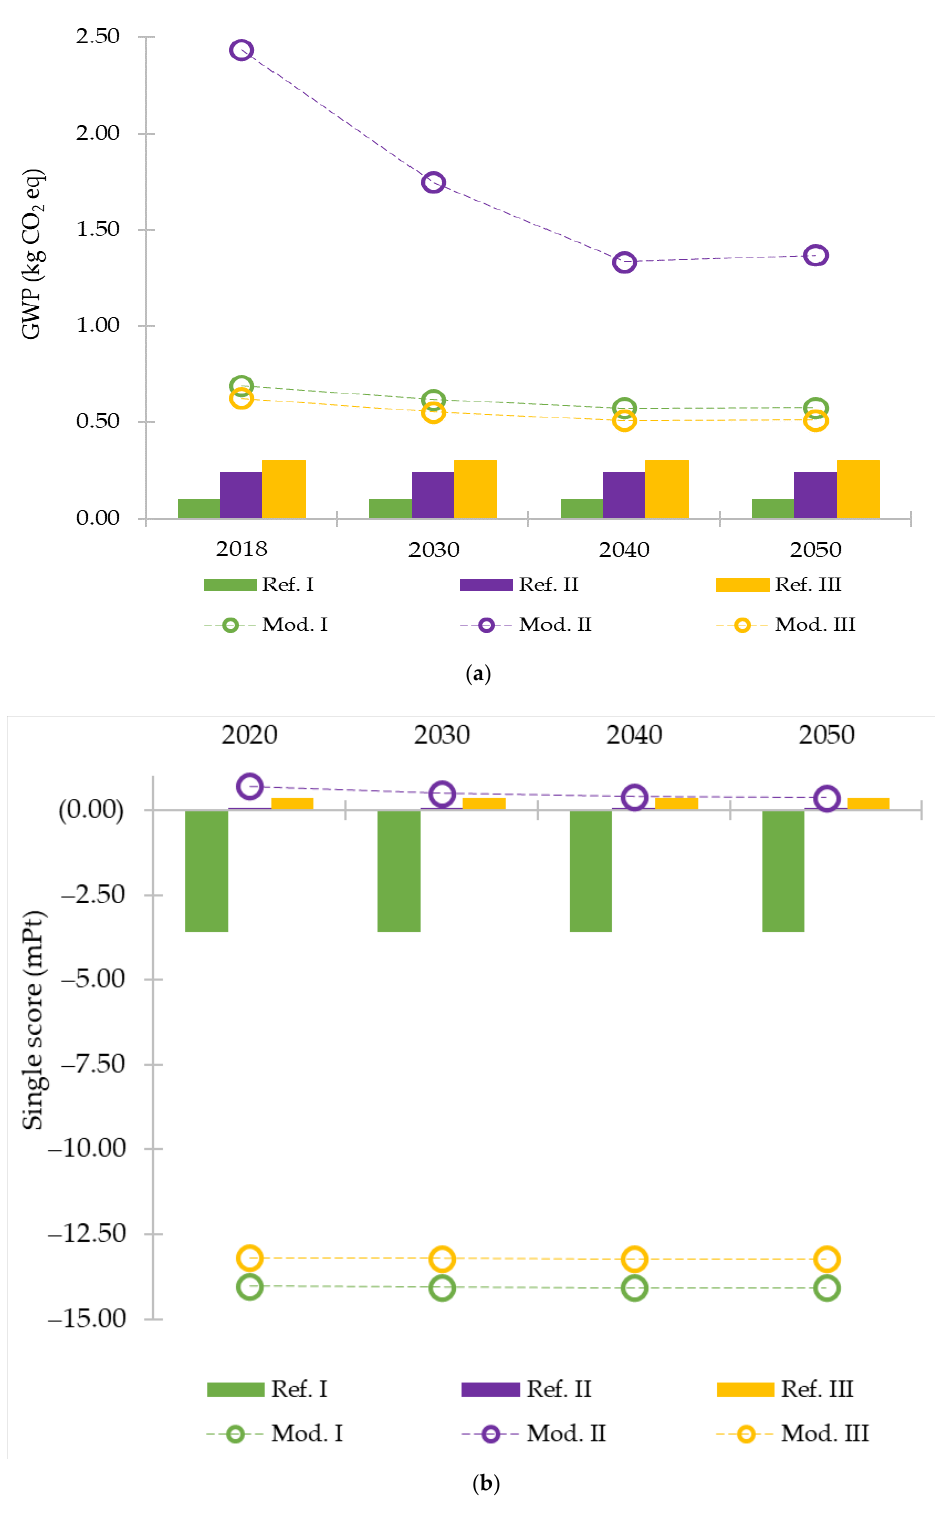
Figure 3. Lifecycle impact assessment results for ( a ) GWP and ( b ) single score, for the functional unit of 1 m 3 of produced and utilised CH 4 .